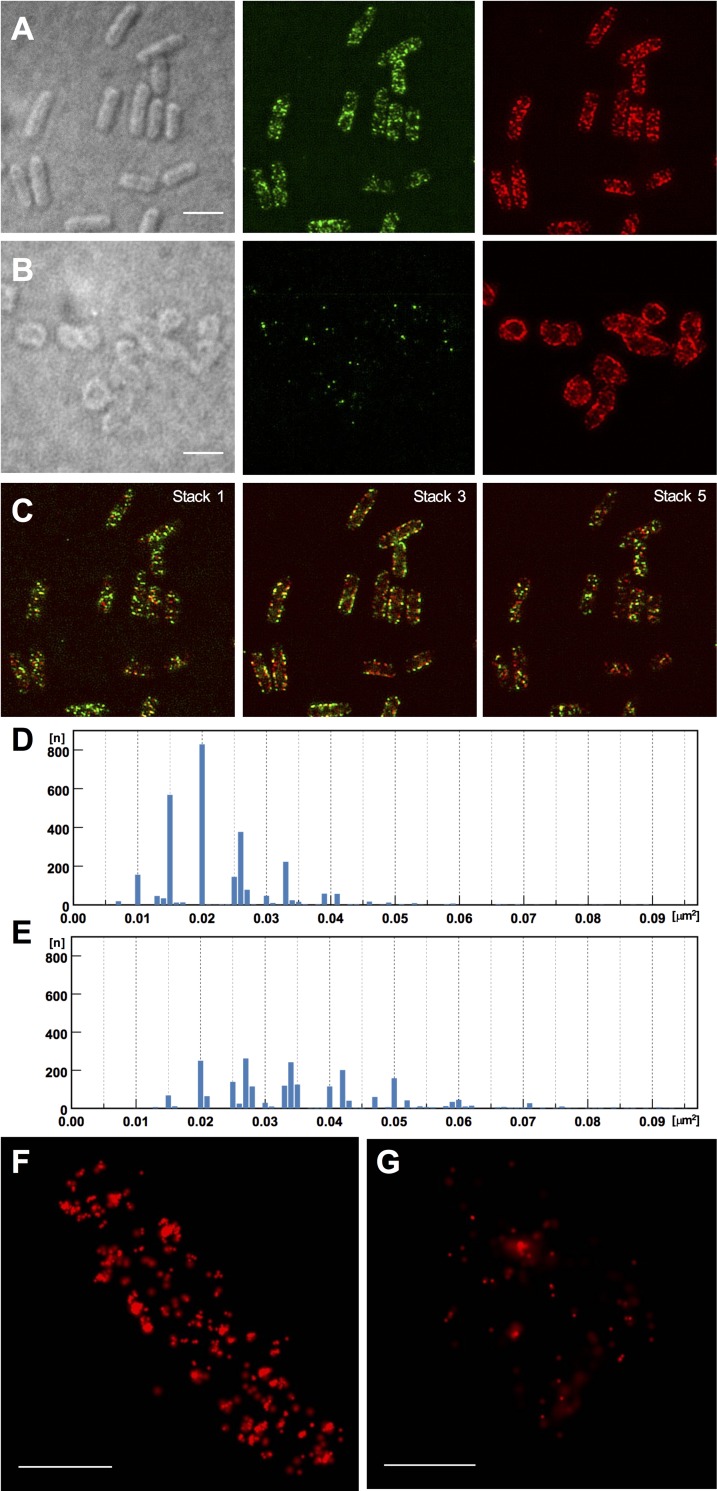
Super-resolution images of RodZ.Images acquired using SIM: Strains were grown to OD600 = 0.4 in 5-ml LB medium at 30°C with shaking (150 rpm) for 2.5 hrs. (A) wild-type strain MS390. (B) ΔrodZ strain MS5201. Panels: Left, differential interference contrast microscopy. Scale bar = 3 μm; Middle, Detection using the anti-RodZ 12–90 antibody and an anti-mouse Alexa Fluor 488 conjugate; Right, Detection using the anti-MreB polyclonal antibody and an anti-rabbit Alexa Fluor 647 conjugate. Signals of all 5 stacks (each 200 nm) were presented. (C) RodZ and MreB signals in stack 1, 3 and 5 of Fig 6A. (D) Distribution of 2811 dots from 230 wild-type cells observed using SIM (Mean = 0.023 μm2). (E) Distribution of 2358 patches observed using SIM (Mean = 0.036 μm2). Images were acquired using STORM: (F) MS390; (G) MS5201. Scale bar = 1 μm.